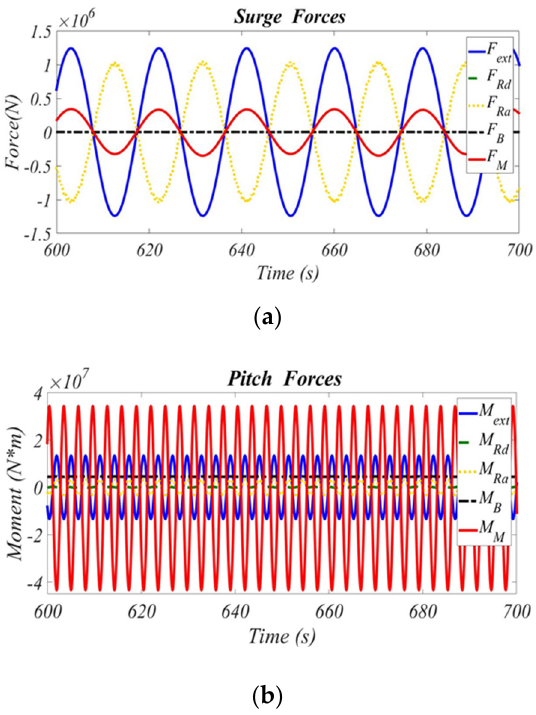
Figure 22. Time histories of wave-load components at ( a ) the surge natural frequency ( f p = 0.053 Hz), and ( b ) the pitch natural frequency ( f p = 0.323 Hz) for the UMaine TLP.